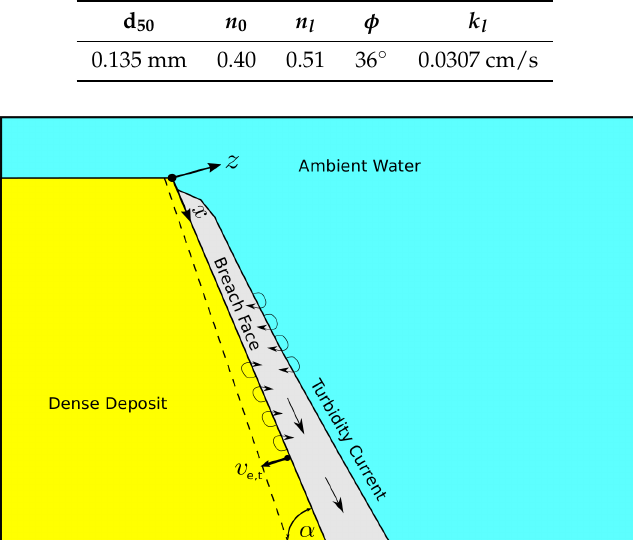
Figure 3. Sketch for the case considered in the numerical simulations; v e , t is the total erosion velocity and α is the slope